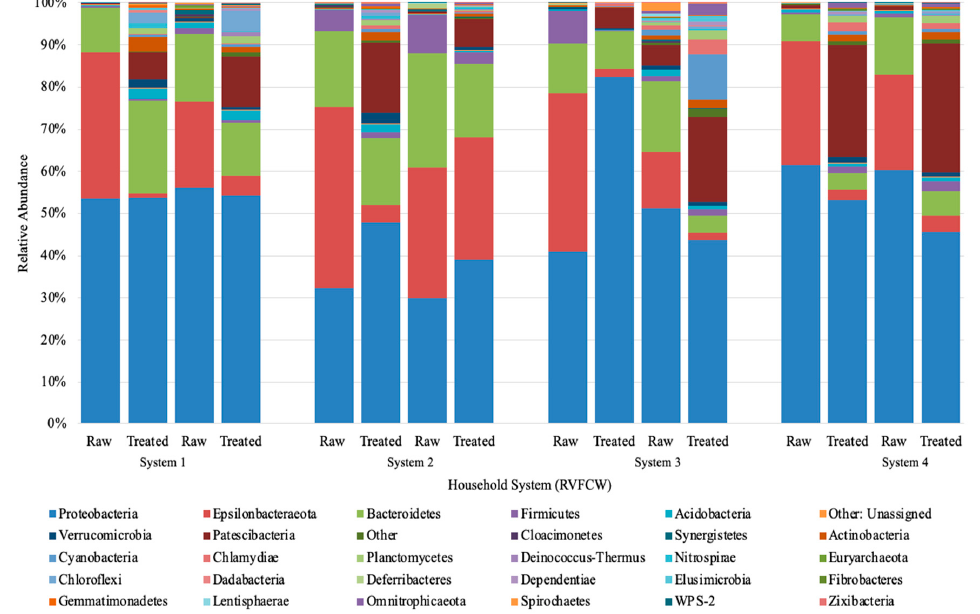
Figure 3. Next-generation Illumina Miseq amplification phylum results for raw and treated greywater. The abundances presented are of duplicates samples sequenced independently from the same system. Phyla with less than 100 OTU were omitted. System 1–4” refers to “CW1–4”.